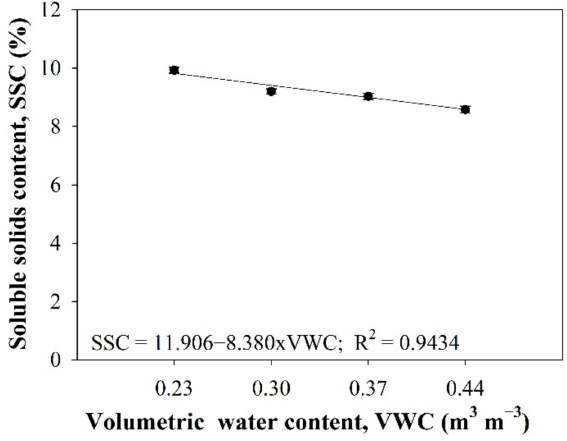
Figure 4. Soluble solids content of two cherry tomato cultivars in response to increasing volumetric water contents. Each data point is the average of four replications ( n = 4). The equations were fit using all replications.